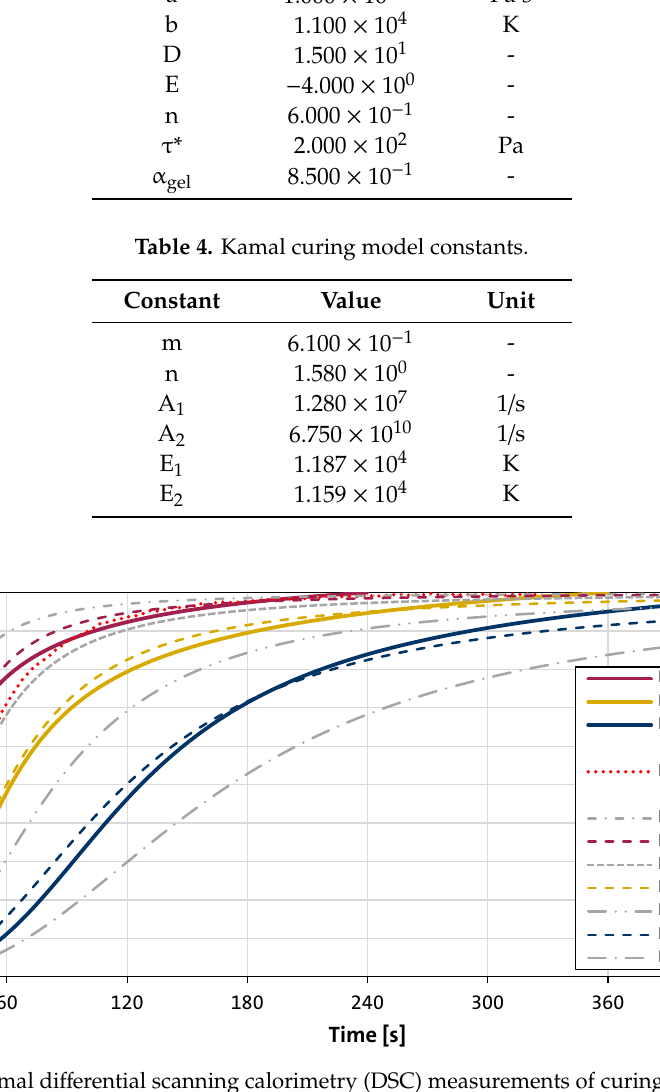
Figure 8. Isothermal differential scanning calorimetry (DSC) measurements of curing HexMC samples at different temperatures and fitted Kamal model curing curves using the identified parameters given in Table 4.